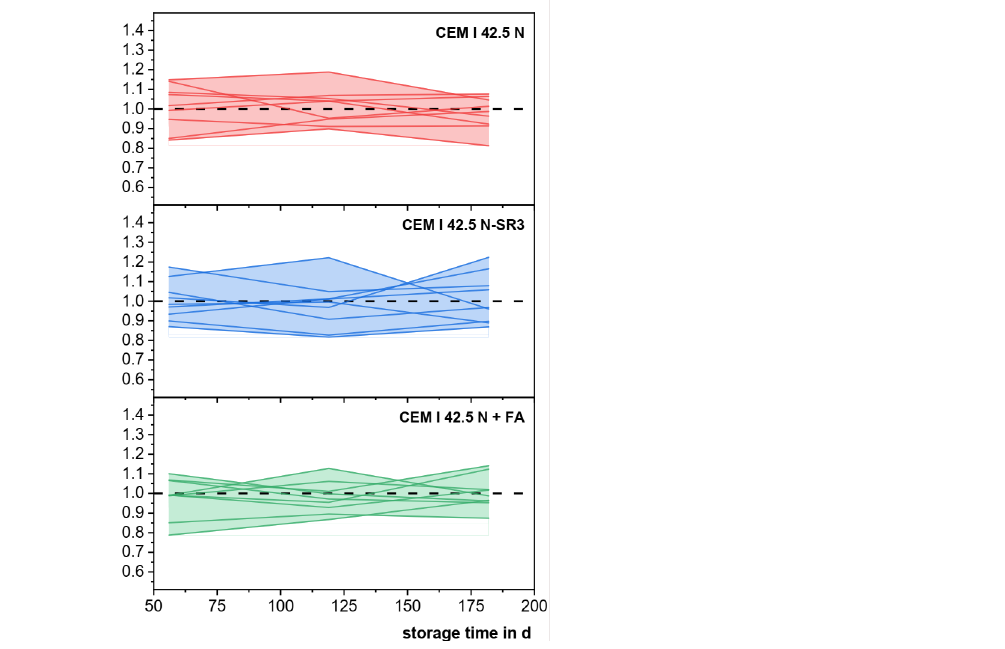
Figure 3. Relative tensile strength (ref.: maturity function) after storage in saturated Ca(OH) 2 solution.